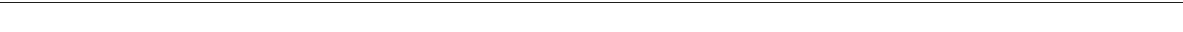
Fig. 3 Modifying length scale of force transmission modi fi es distance between leaders. a Scatter dot plot showing force correlation length in terms of cell number upon chemical modi fi cation, i.e., by treating the cells with blebbistatin and calyculin A compared to the control, and upon physical modi fi cation, i.e., by changing substrate stiffness. b Scattered dot plot showing distance between leaders in terms of cell number upon chemical and physical modi fi cations. c Representative images of control, blebbistatin treated, calyculin A treated collectives and collectives on gels with varying stiffness 4 KPa, 11 KPa, and 90 KPa (from left to right) as stained for actin, show changing distance between leader cells upon chemical modi fi cation and physical modi fi cations. d Representative phase contrast images (top panel) and landscapes of average normal stress from control blebbistatin treated, calyculin A treated collectives and from collectives on gels with varying stiffness, 4 KPa, 11 KPa and 90 KPa (from left to right), as measured during migration. Note that the Calyculin A treated and 90KPa stress pro fi les have a different scale due to high stress levels. Cell density was kept constant = 3000 cells/mm 2 . Line represents mean and errors bars represents S.E.M. **** P < 0.0001, Mann – Whitney test. Scale bars, 100 μ m. Data collected from at least three independent